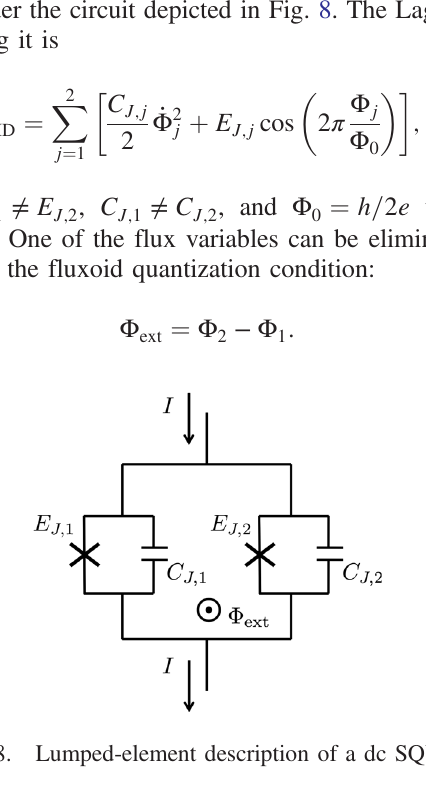
FIG. 8. Lumped-element description of a dc SQUID.